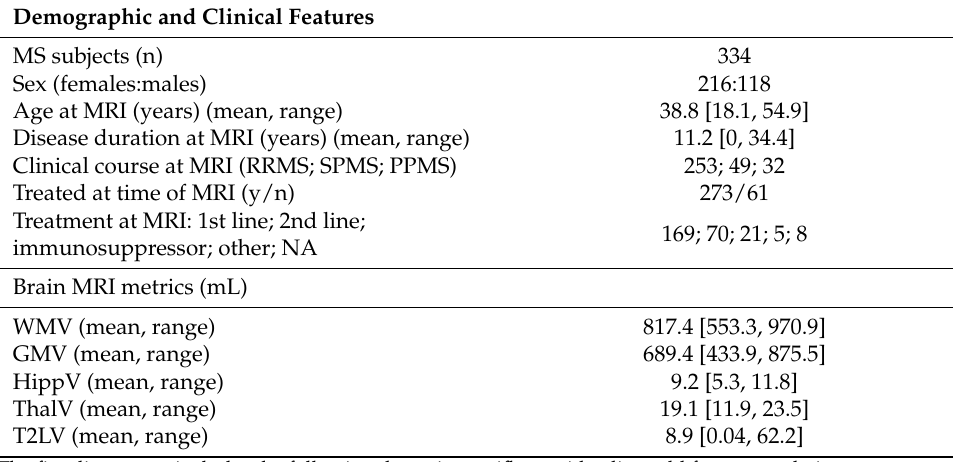
Table 1. Demographic, clinical and MRI measures of the cohort.